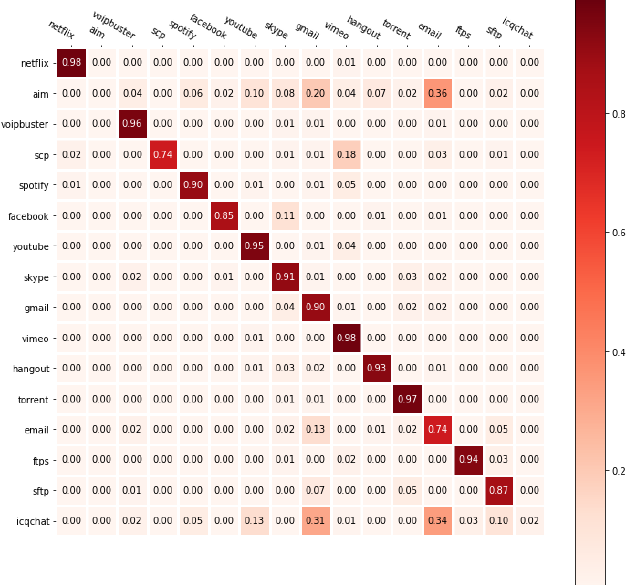
Figure 13. Confusion matrix of dynamic application federated